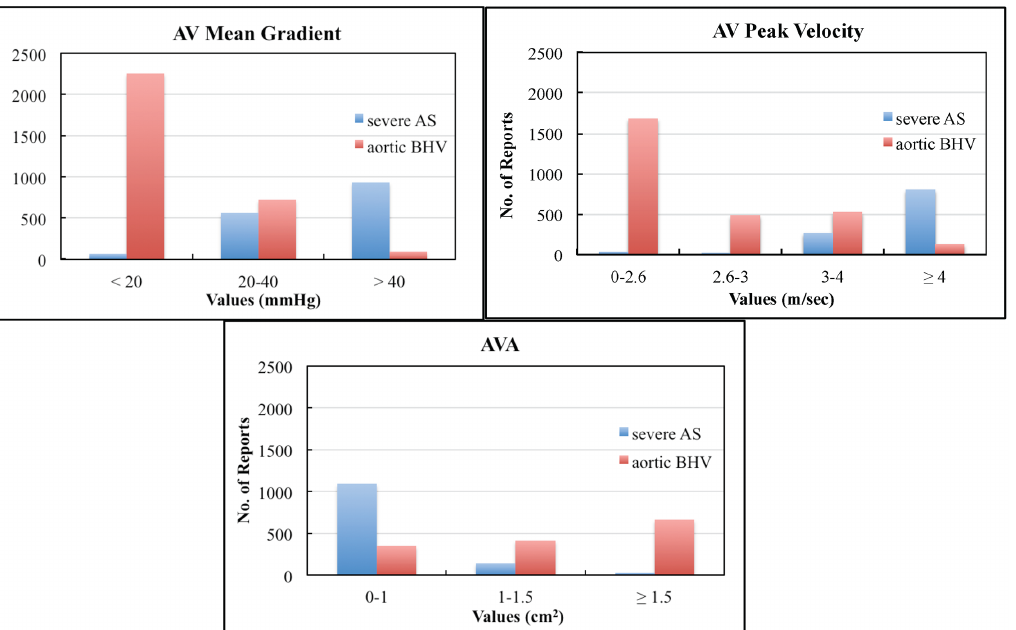
Fig 2. Number of reports containing specified ranges of values from patients identified by EchoInfer as having either severe aortic stenosis (AS) or an aortic bioprosthetic heart valve (BHV) demonstrating the expected pattern for aortic valve (AV) mean gradient, AV peak velocity, and aortic valve area